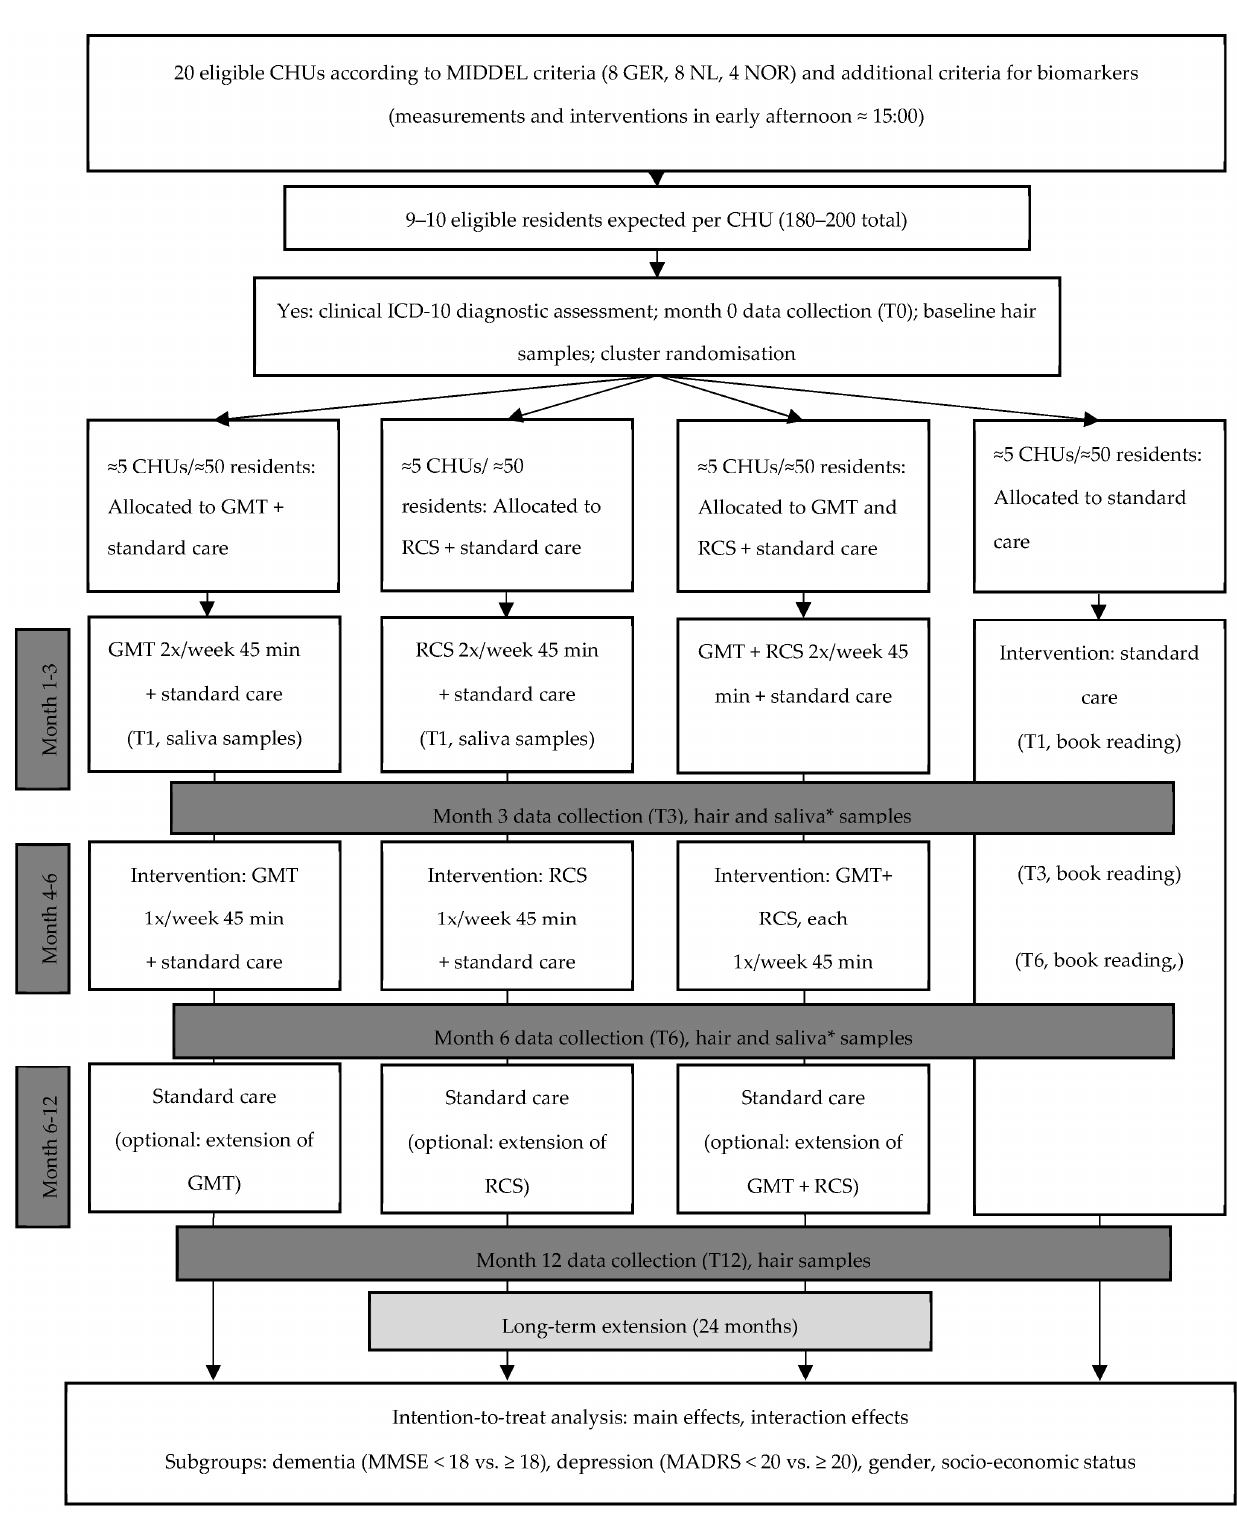
Figure 1. Flowchart illustrating the design of the substudy integrated within the Music Interventions for Dementia and Depression in ELderly care (MIDDEL) trial. * In the CHUs in the combination group (GMT + RCS), no saliva samples were collected.